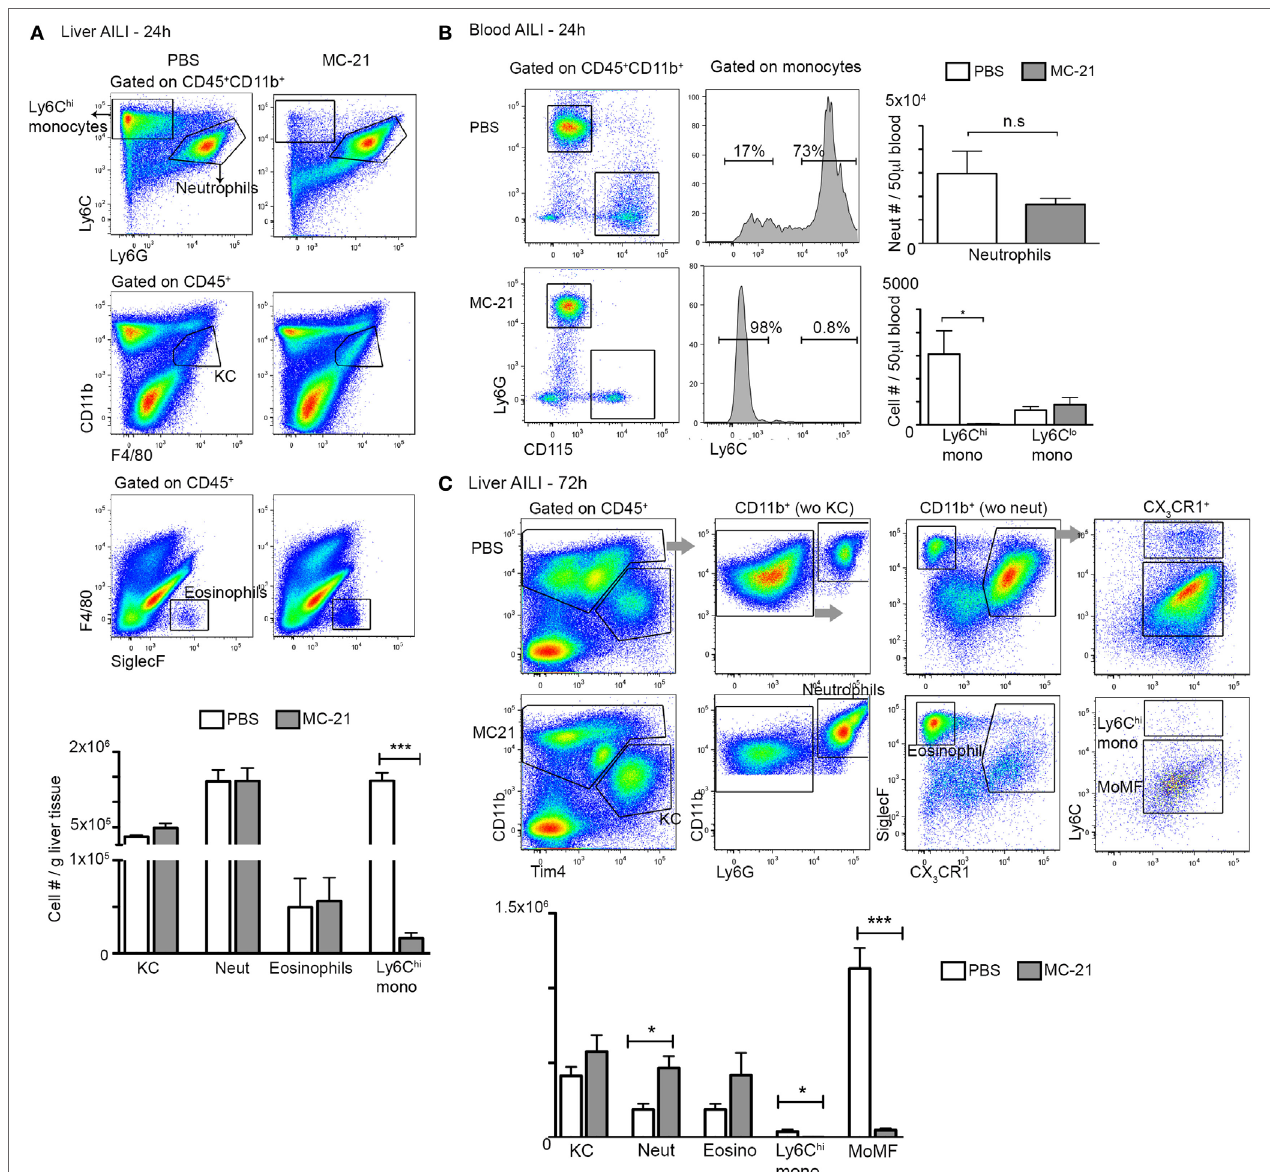
FigUre 2 | Mc-21 treatment induces the specific ablation of ly6c hi monocytes and MoMF . (a) Flow cytometry analysis of hepatic non-parenchymal cells at 24 h following acetaminophen-induced liver injury (AILI) in mice injected with MC-21 or phosphate-buffered saline (PBS). Below, graphical summary of Kupffer cell (KC), neutrophil, eosinophil, and Ly6C hi monocyte cell numbers normalized for liver tissue mass. Note the specific depletion of Ly6C hi monocytes. (B) Flow cytometry analysis of peripheral blood of control versus MC-21-treated mice showing Ly6C hi and Ly6C lo CD115 + monocyte subsets as well as CD115 − Ly6G hi neutrophils. Next, graphical summaries showing the cell numbers per 50 µL blood of neutrophils and Ly6C hi and Ly6C lo monocyte subsets at 24 h following AILI. (c) Flow cytometry analysis of hepatic non-parenchymal cells at 72 h following AILI in mice injected with MC-21 or PBS. Below, graphical summary of KC, neutrophil, eosinophil, Ly6C hi monocyte and monocyte-derived macrophage (MoMF) cell numbers normalized for liver tissue mass. Note the specific depletion of Ly6C hi monocytes and their MoMF descendants. Data are presented as mean ± SEM; n ≥ 5 mice for each time point. Data were analyzed by unpaired, two-tailed t -test, comparing each time between PBS and MC-21-treatments, and are presented as mean ± SEM with significance: * p < 0.05 and *** p < 0.001 ( n ≥ 5 mice/group). Experiments were repeated at least